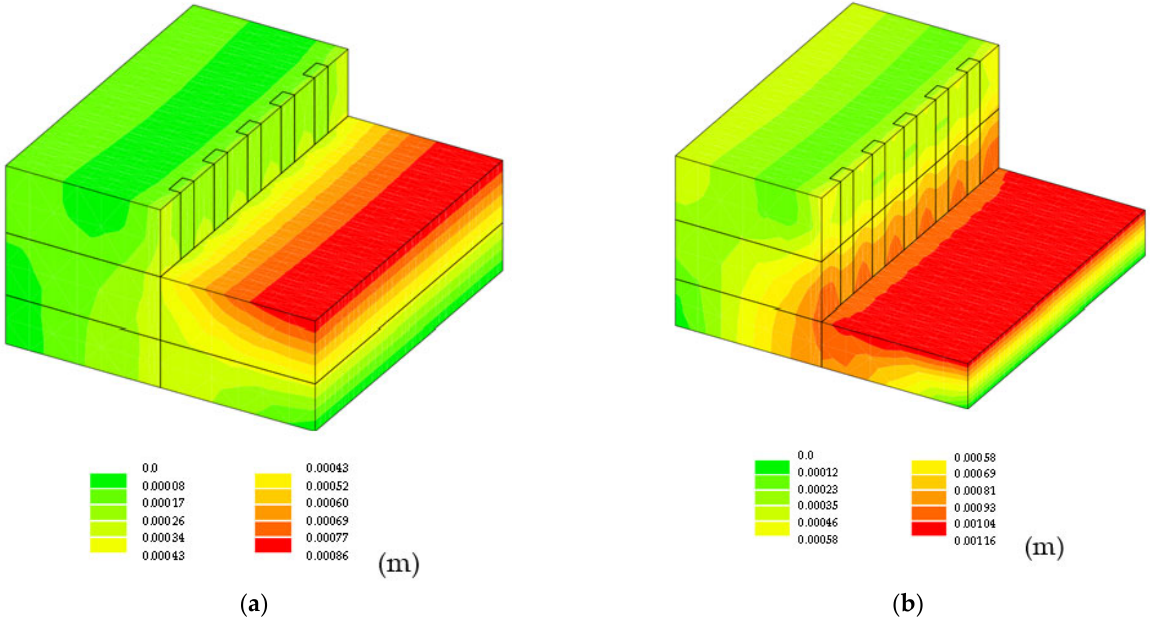
Figure 11. Iso ‐ value of the total displacement obtained with the 3D FEM analysis for ( a ) the first ‐ stage stratum excavation and ( b ) the second ‐ stage stratum excavation.